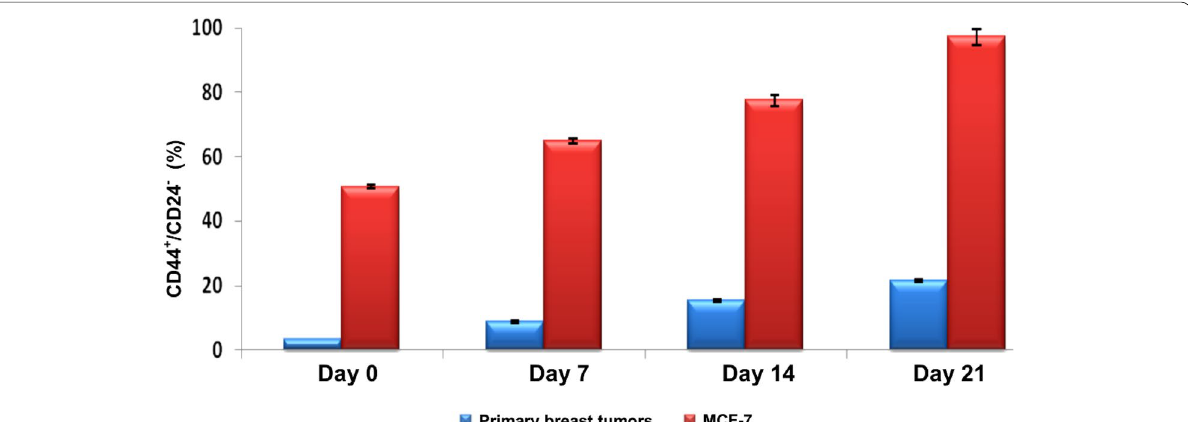
Fig. 6 Proportions of cancer stem-like cells with CD44 + /CD24 − /low phenotype from primary breast tumors and MCF-7 cell line on day 7, 14, and 21